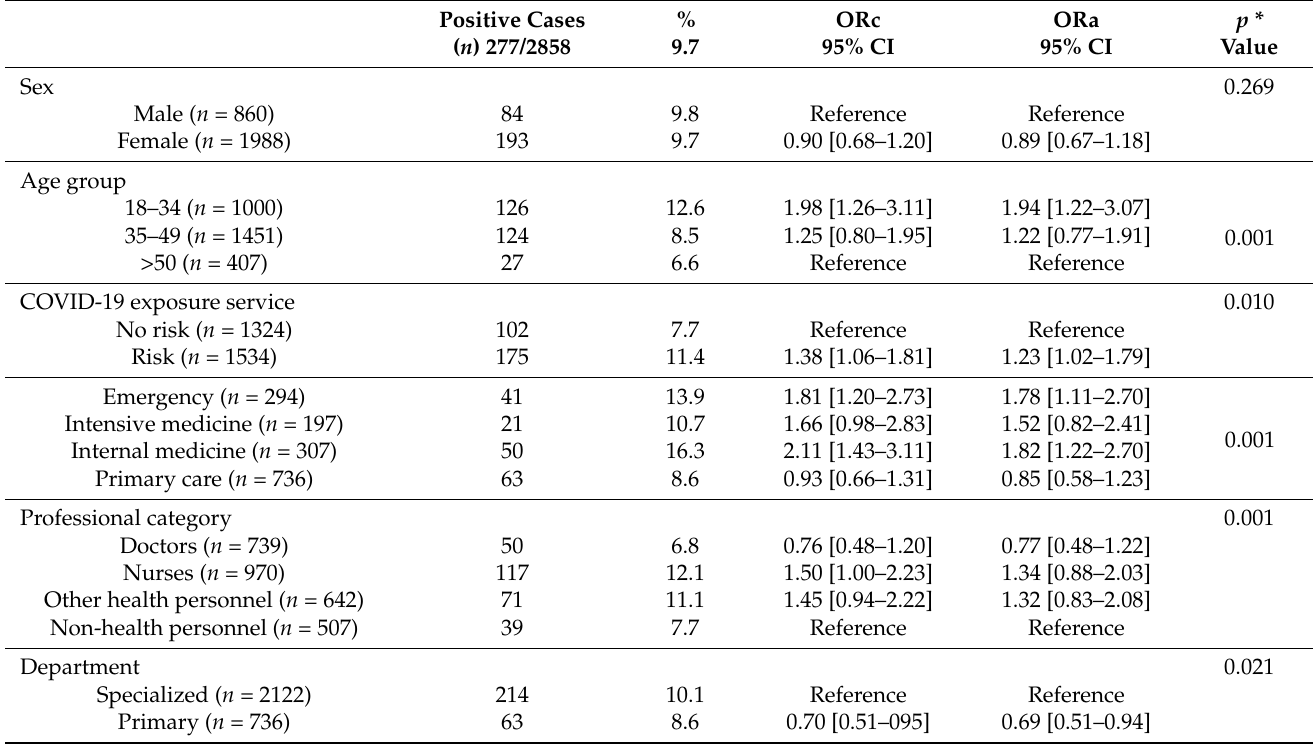
Table 3. Confirmed cases of SARS-CoV-2 infection in the health professionals of the Elche-Crevillente and Torrevieja health